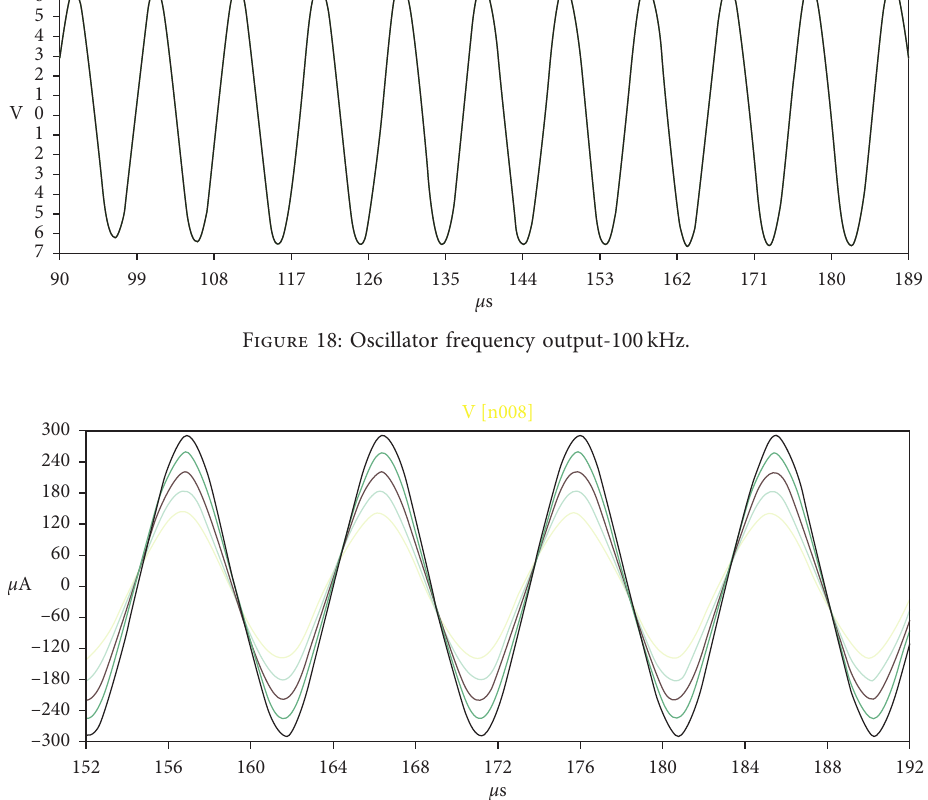
Figure 19: Current sense-capacitance varied from 10pF to 50pF.